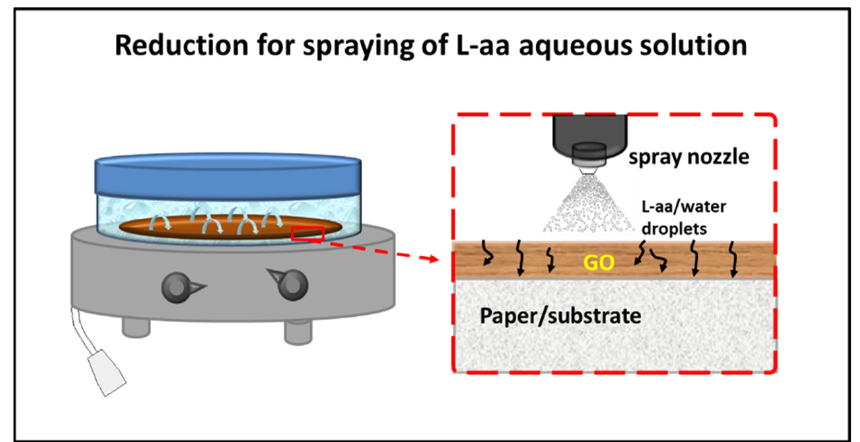
Figure 2. Scheme of the reduction of GO film deposited on paper/substrate by spraying of a L-aa aqueous solution [67].